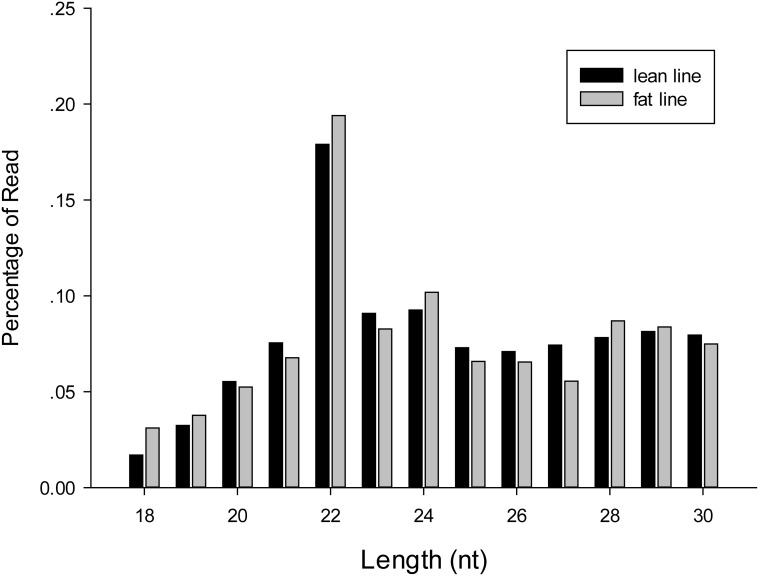
Length distribution of small RNA read sequences in fat and lean chicken lines.